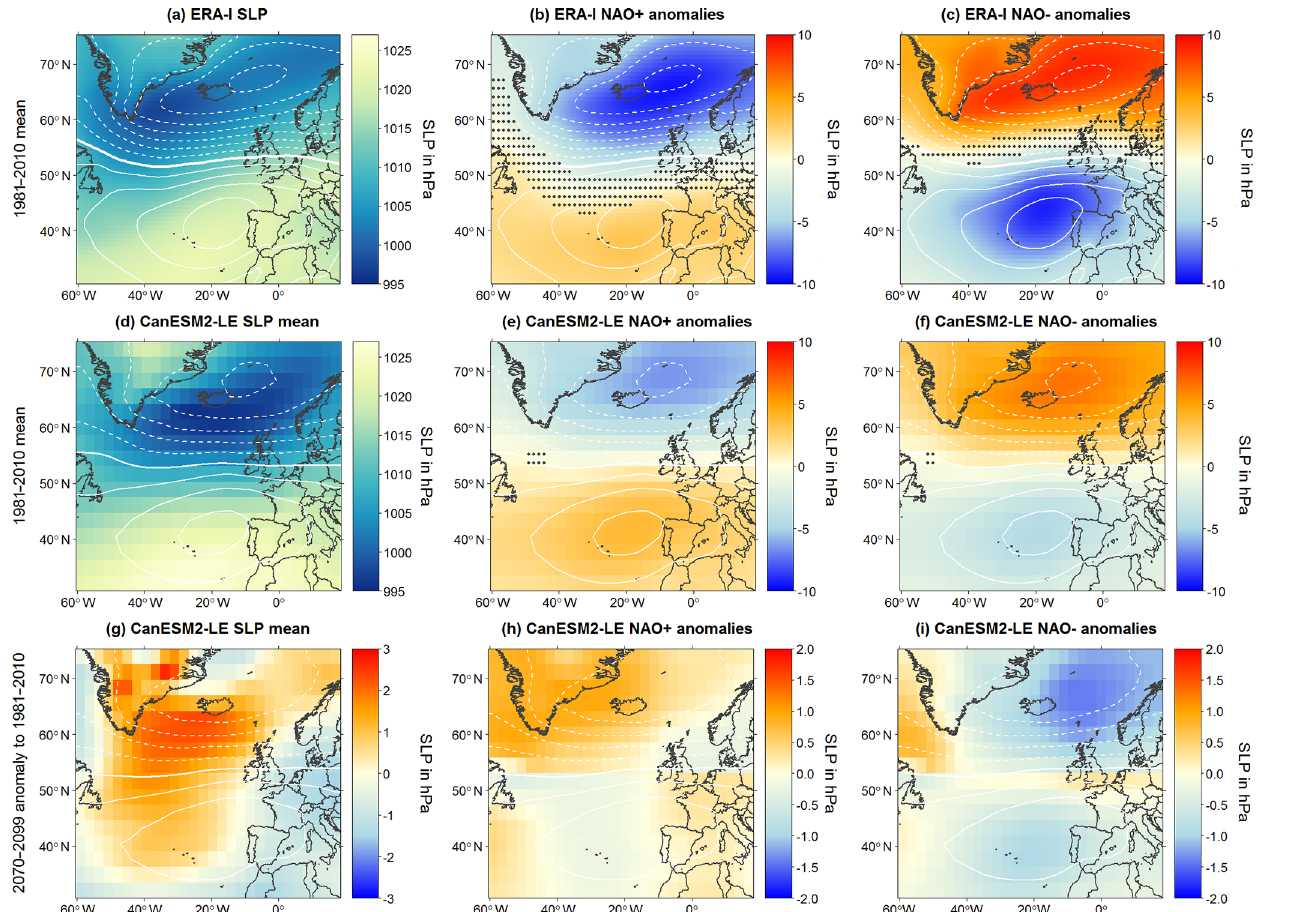
Figure 4. NAR winter mean SLP (hPa) composites in ERA-I (a–c) and CanESM2-LE (d–i) data showing long-term neutral condi- tions (a, d, g) , NAO positive (b, e, h) and negative anomalies (c, f, i) , (a–f) for 1981–2010 and (g–i) 2070–2099 changes with respect to 1981–2010 in GCM data. White isolines indicate the difference between positive and negative anomalies by a step of 2.50hPa, as, e.g., in Hurrell (1995); solid: positive, dashed: negative, bold line: zero. Grey stippling in subpanels (b–c) and (e–f) indicates regions where the anomaly is smaller than the standard error of the composite samples.